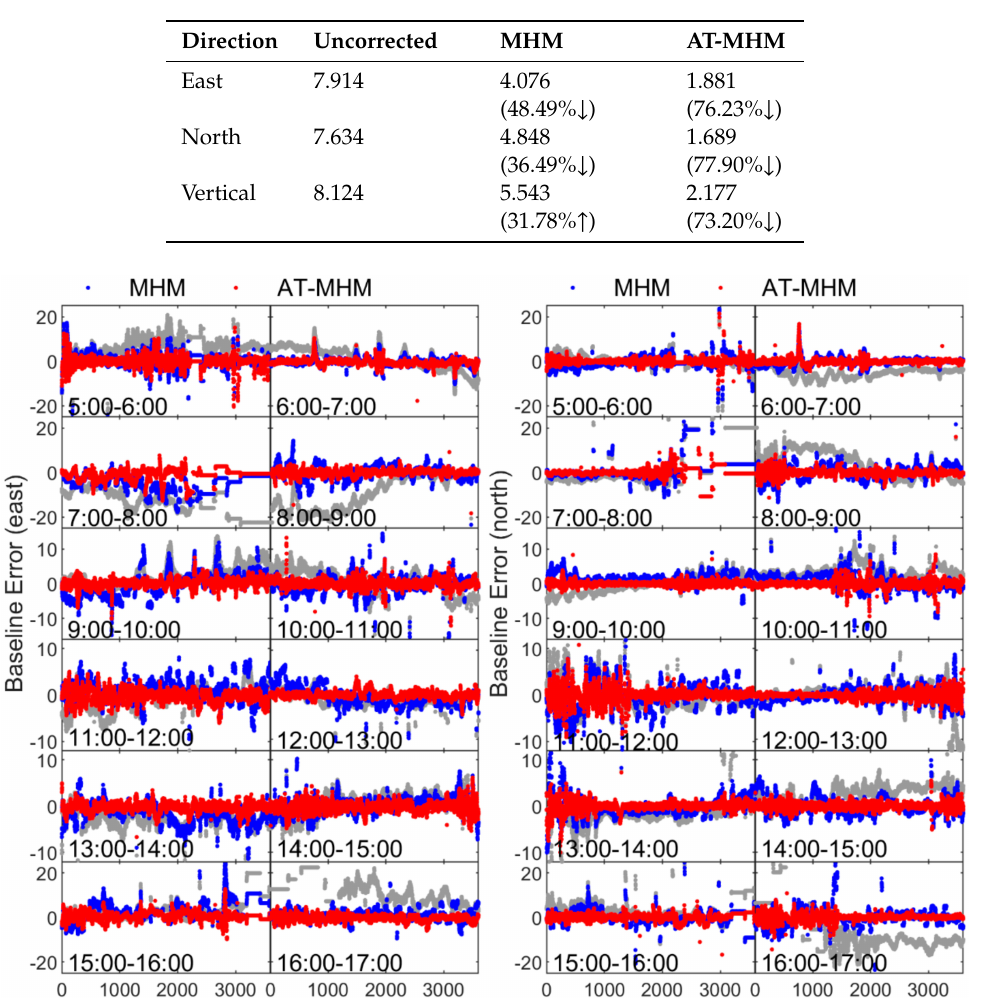
Figure 15. Comparison of the multipath correction e ff ect of MHM and AT-MHM modeled by DOY152 data on DOY153. Left panel , the east direction; Right panel , the north direction. X-axis unit: second, Y-axis unit: